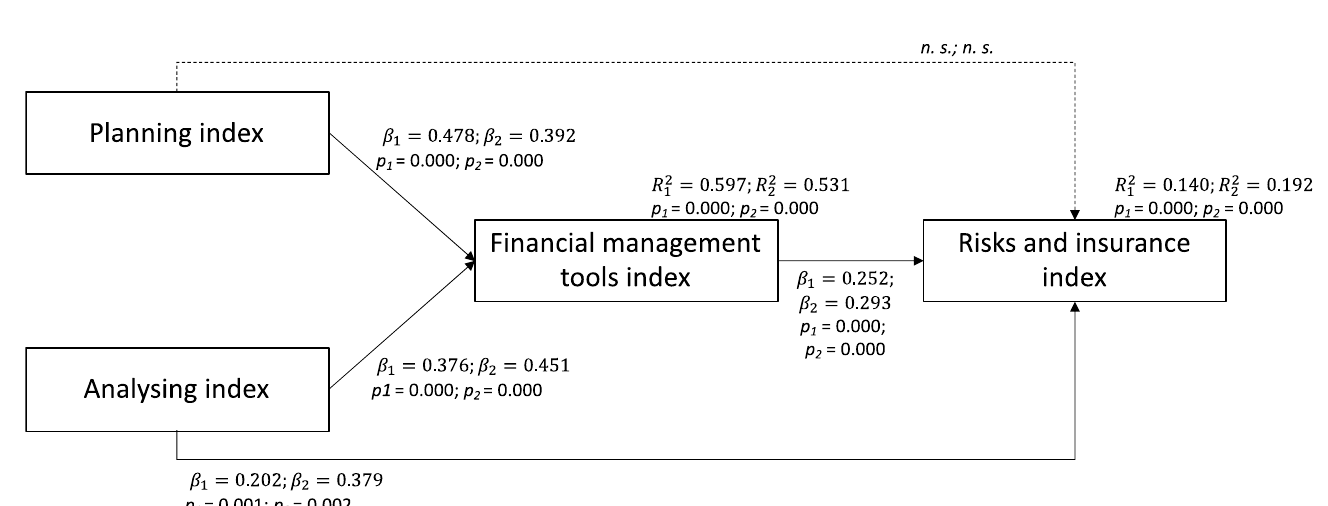
Figure 2. Block diagram of path model.